Question: Express in one sentence what the figure is showing.
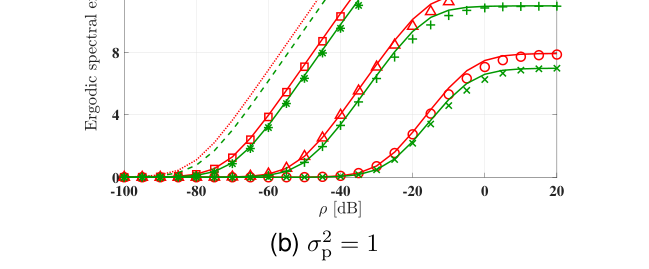
Answer: Theoretical analysis (33), (34) and simulation results of the ergodic achievable rate R versus the transmit power ρ for different number of RHS elements, with imperfect RHS phase shift design, i.e. σ2 p > 0.